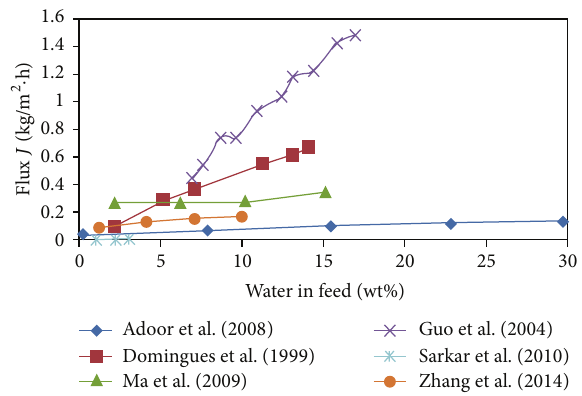
Figure 4: Effect of feed water concentration (wt%) on flux of water- organic pervaporation system.